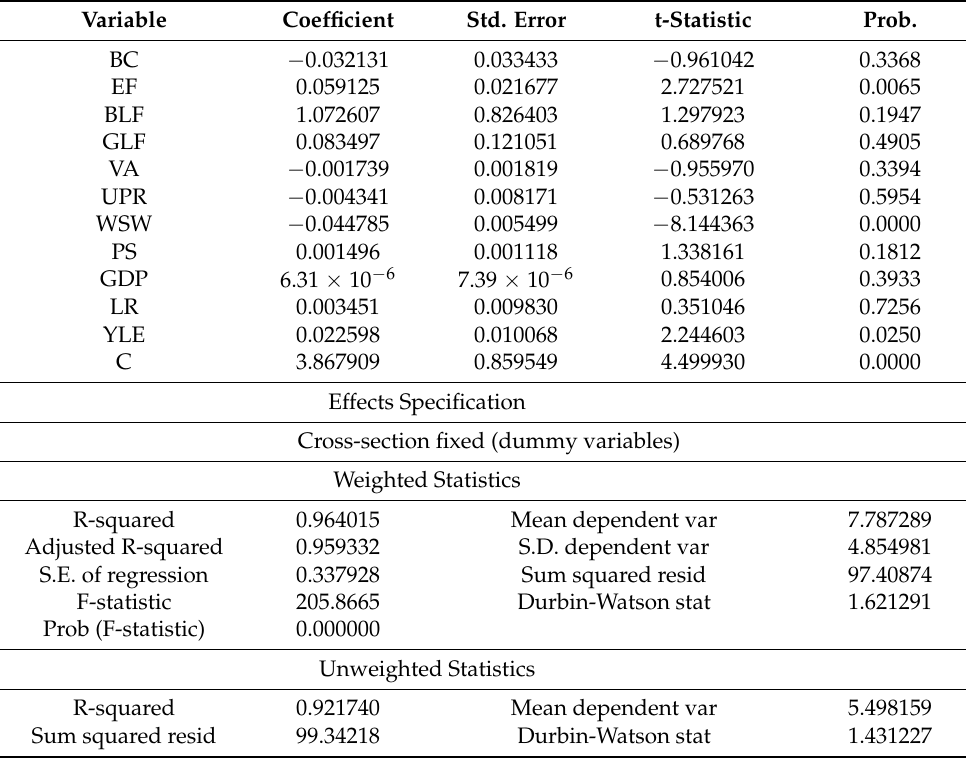
Table 4. Cross-section fixed effects panel regression